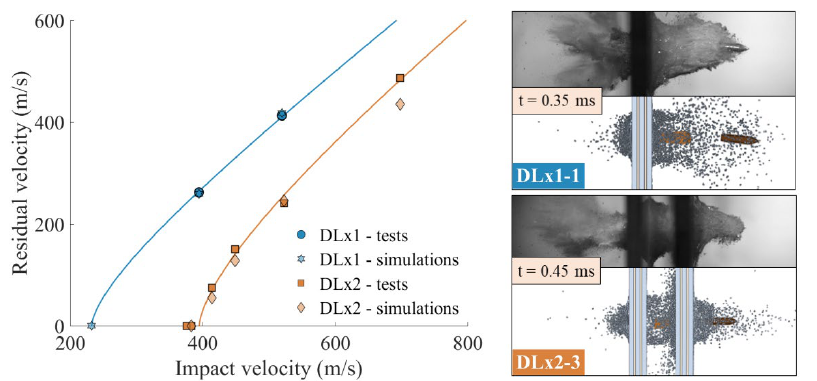
Fig. 4. Experimental versus numerical ballistic impact tests. Solid lines depict the ballistic limit